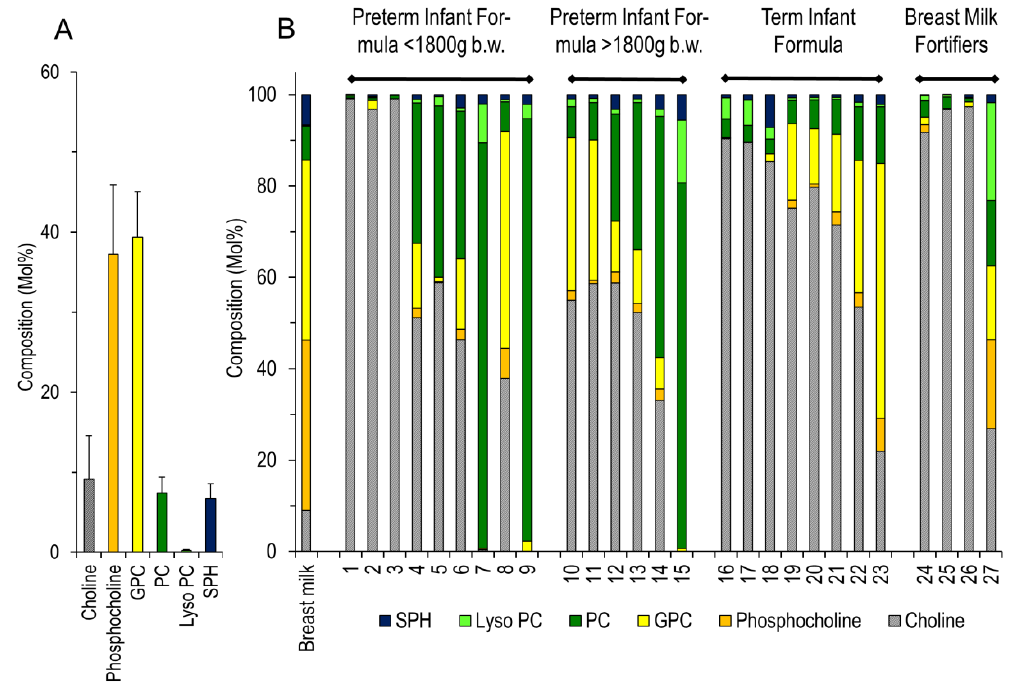
Figure 3. Molar Composition of Preterm Infant Breast Milk. ( A ) Medians and interquartile ranges, and ( B ) Individual components containing a choline moiety in formula/fortifiers compared to breast milk. For details, see the legend to Figure 2. Individual product numbering is indicated in Table 1.